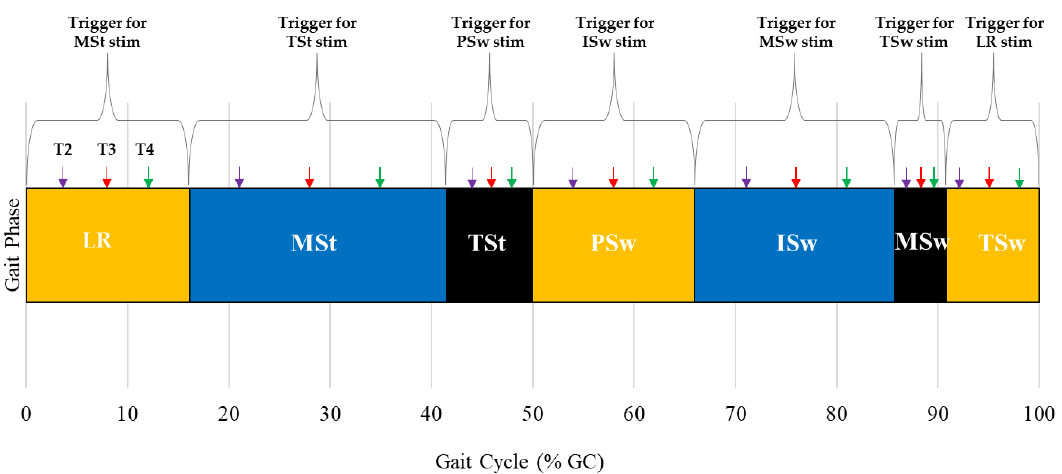
Figure 1. A representation of trigger timing for each gait phase. Purple, red, and green arrows illustrate the percentage delay added to gait phase onset for T2 (25% gait phase duration), T3 (50% gait phase duration), and T4 (75% gait phase duration), respectively. T2 – T4 triggered stimulation (stim) for the upcoming phase. The same trigger condition was applied to all gait phases. T2 , 25% gait phase duration delay trigger; T3, 50% gait phase duration delay trigger; T4, 75% gait phase duration delay trigger. LR — Loading Response, MSt — Mid- Stance, TSt — Terminal Stance, PSw — Pre-Swing, ISw — Initial Swing, MSw — Mid-Swing, TSw — Terminal